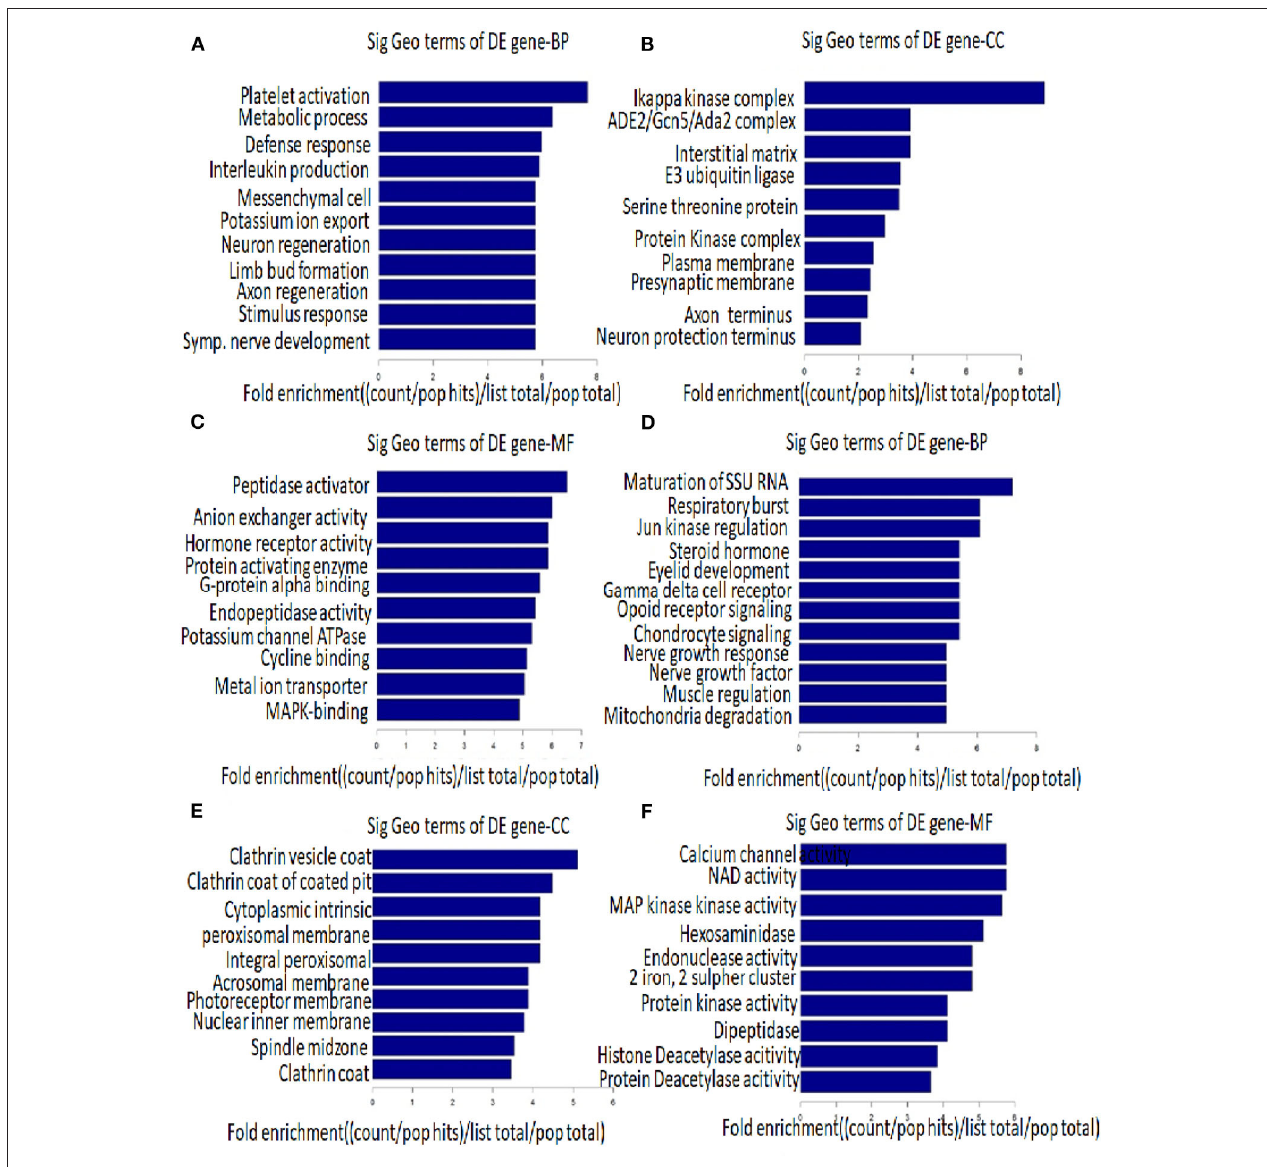
FIGURE 3 | Gene ontology (GO) analysis. The top 10 GO terms associated with coding gene functions of upregulated lncRNAs (A–C) and downregulated lncRNAs (D–F) are